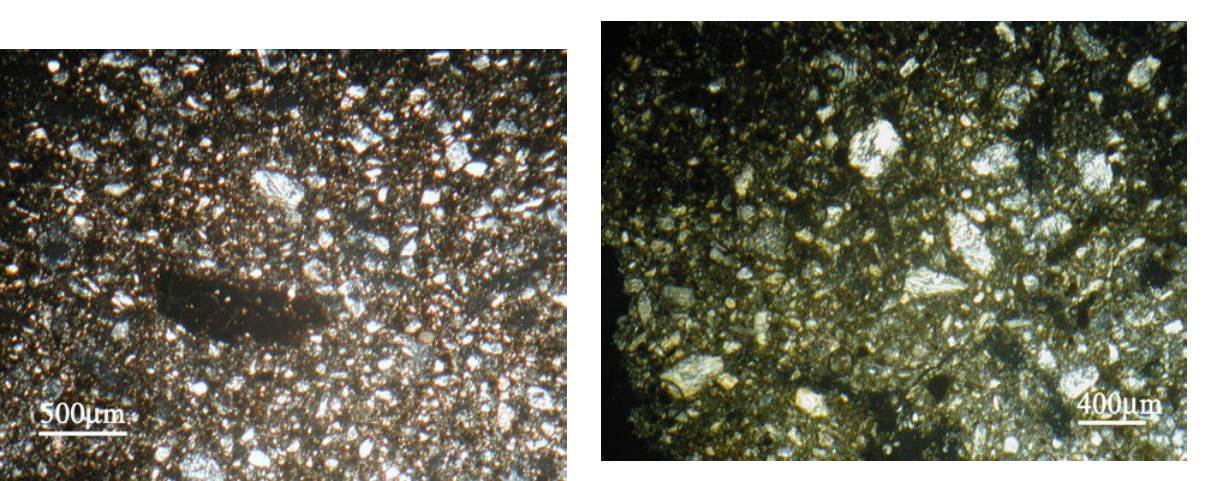
Figura 8. Product N, sample 20 - Cross Nicols image: particular of the binder of brown colour constituted by lime and gypsum; gyp- sum, calcite and iron oxides are visible in the aggregate of bigger